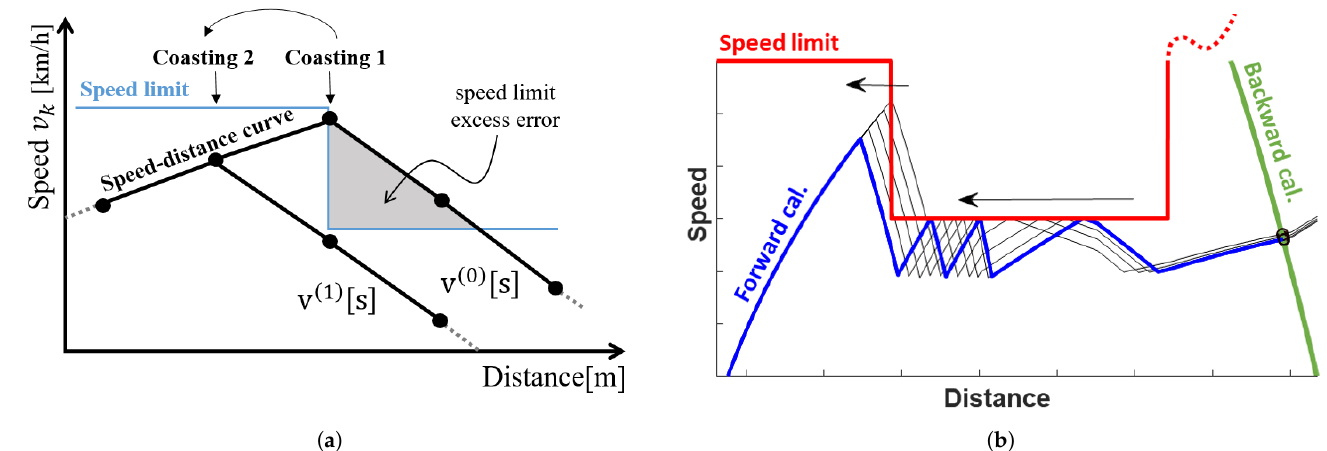
Figure 4. Speed error correction method for mTPS. ( a ) Speed error correction method. ( b ) An example of speed error